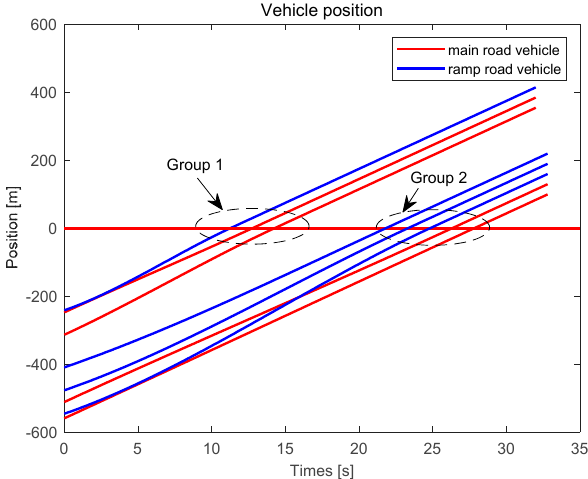
Figure 8. Position trajectory of vehicles for case study 2.